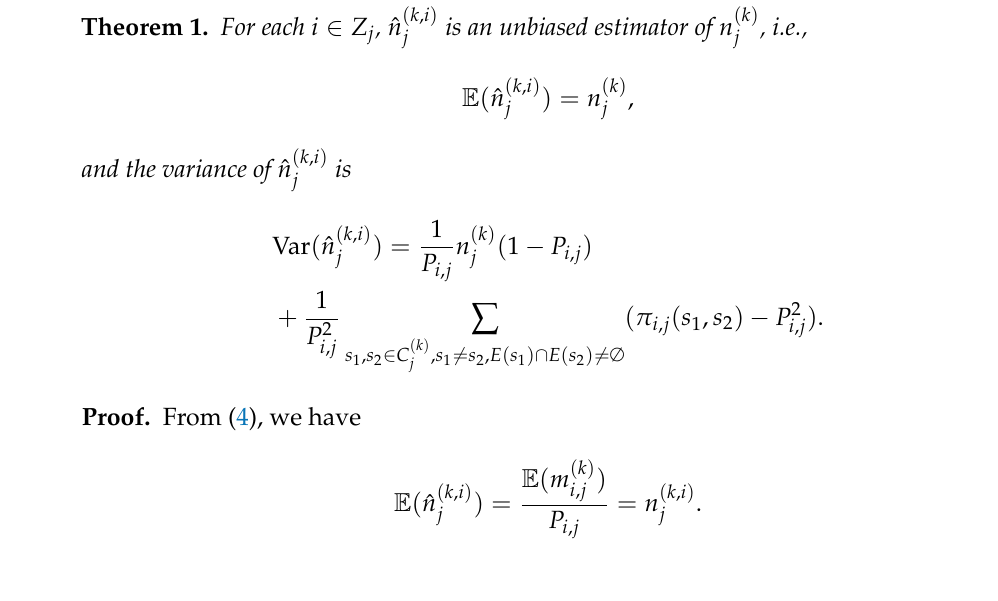
Figure 5. Compute π 1,2 ( s 1 , s 2 ) and π 2,2 ( s 1 , s 2 ) for the undirected three-node